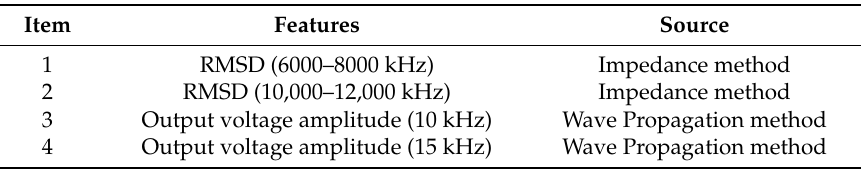
Table 5. Extracted features.